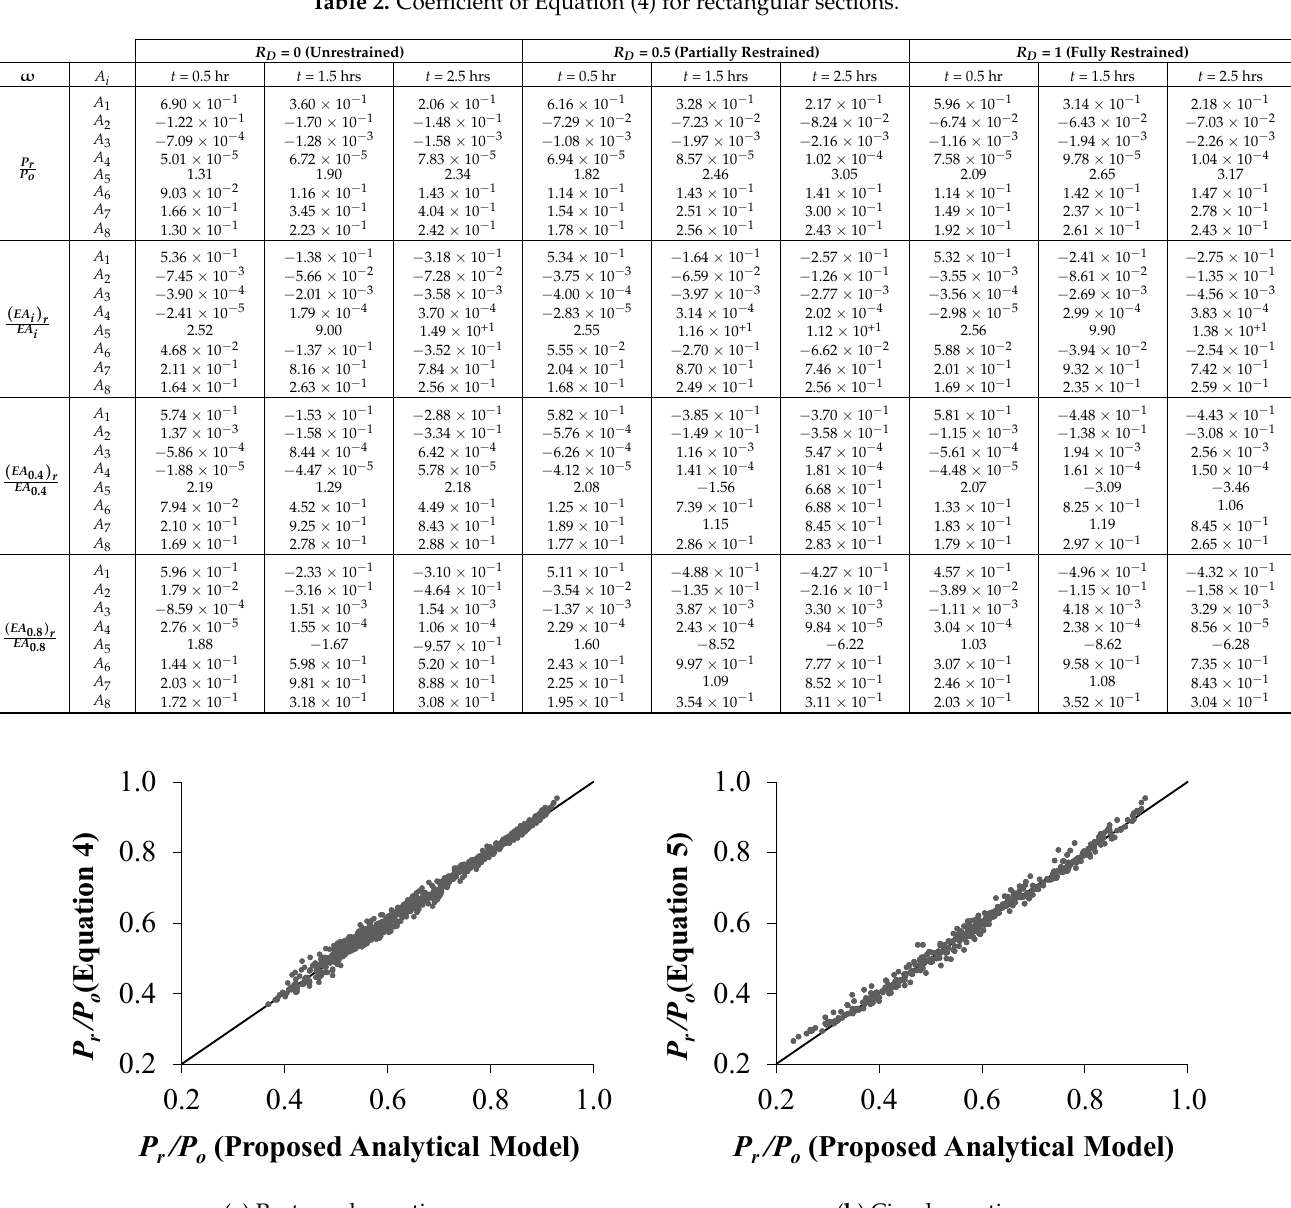
Figure 15. Validation of the proposed Equations (4) and (5) for residual